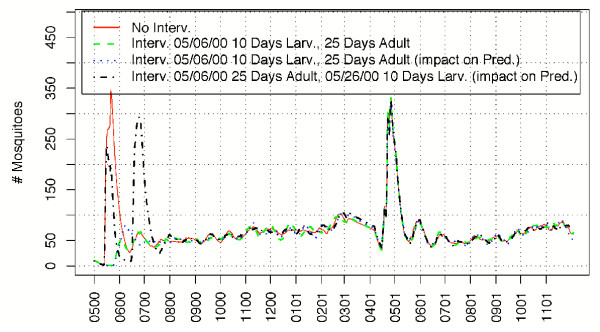
An. gambiae adult abundance with larval and adult control intervention and predators